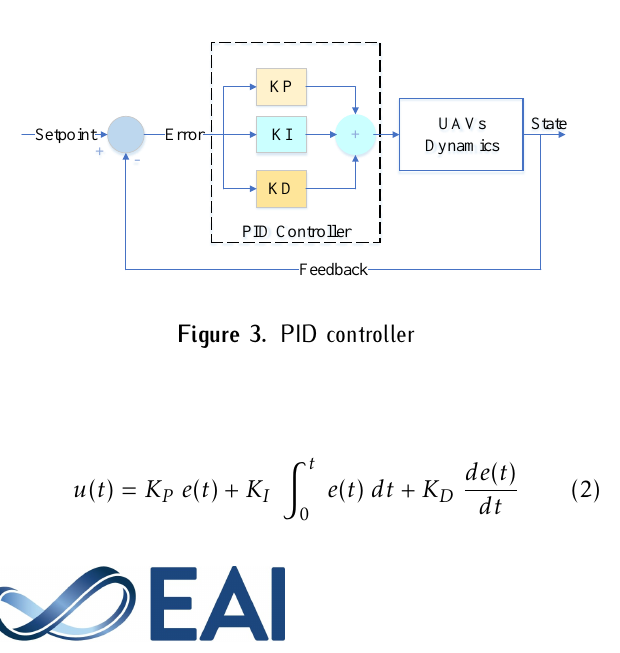
Figure 2. The lateral and rotational movement principle of quadrotor